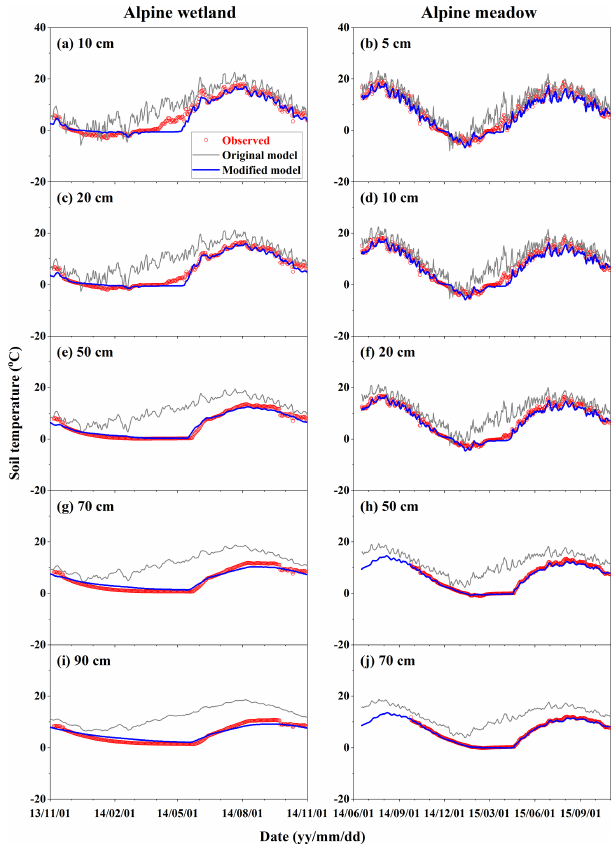
Figure 1. Observed and simulated daily profile soil temperature from the alpine wetlands and meadows by the original and modi- fied models. The legend in panel (a) applies for all